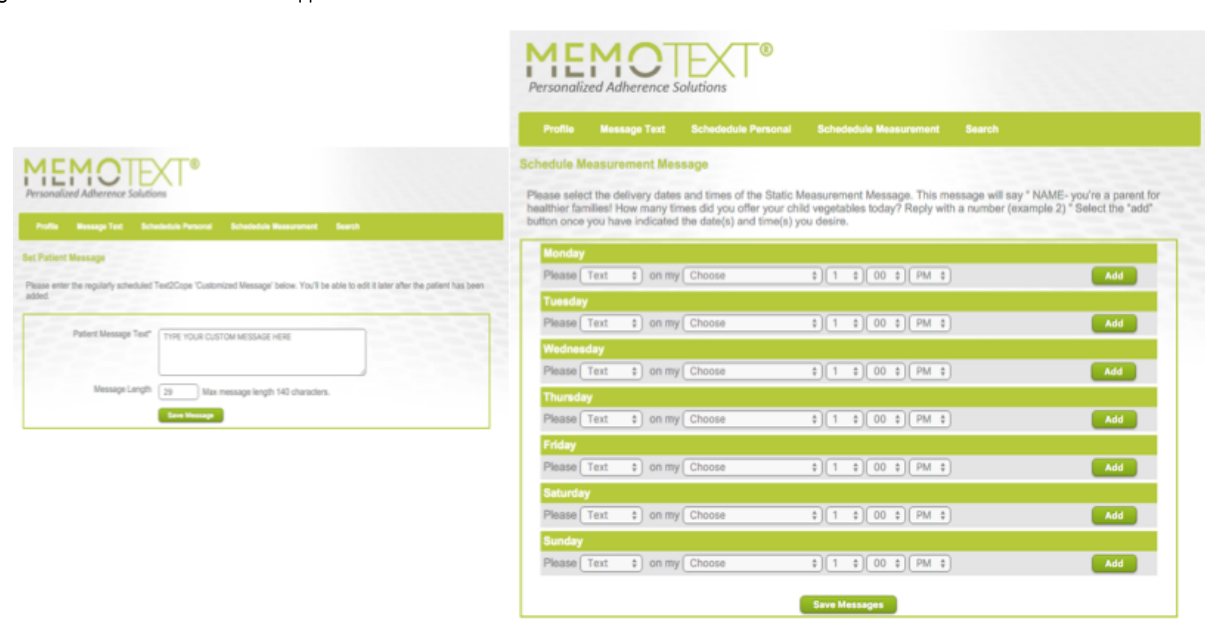
Figure 2. TEXT2COPE-Memotext application